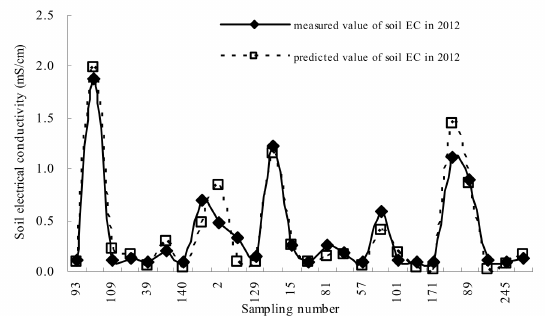
Figure 5. Comparison of predicted and measured value in October 2012.